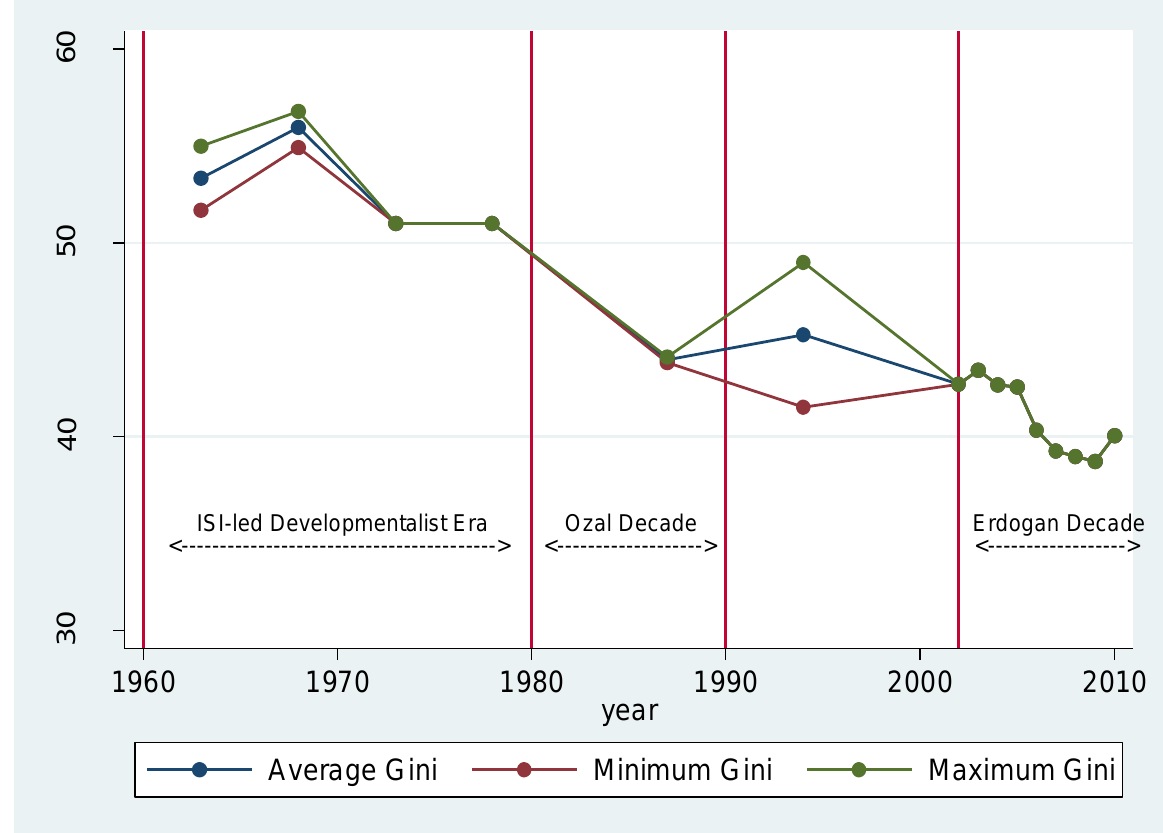
Figure 2 : Income Inequality in Turkey,